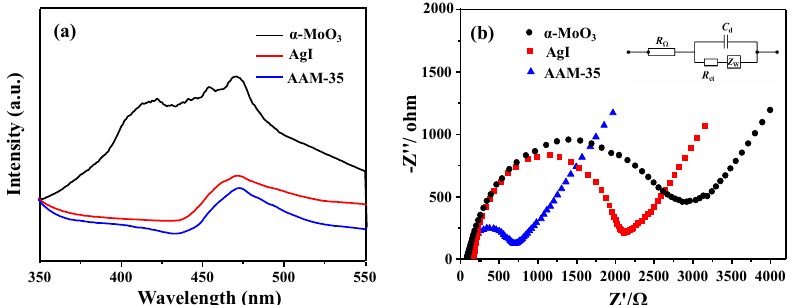
Figure 5. ( a ) Photoluminescence (PL) spectra of pure α -MoO 3 , AgI and AAM-35 heterojunction, ( b ) EIS plots of α -MoO 3 , AgI and AAM-35 heterojunction. The inset is an ideal equivalent circuit for the working photoelectrode.